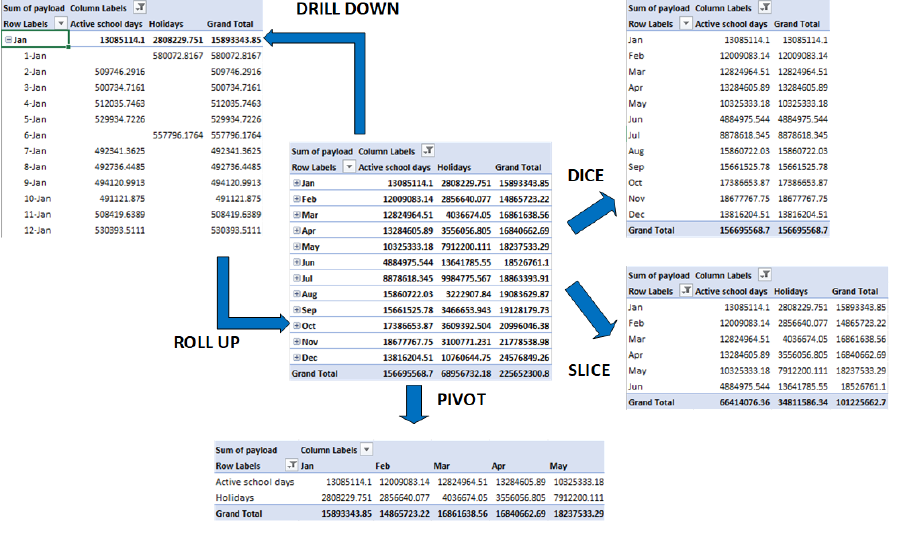
Fig. 5 Example OLAP